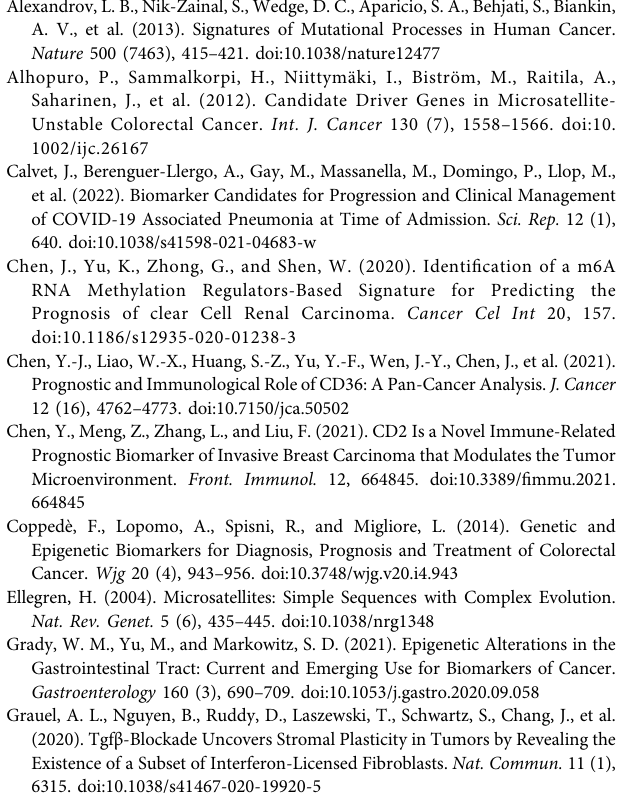
Supplementary Figure 5 | Kaplan-Meier analysis for DSS according to OAS3 expression. Only statistically signi fi cant cancers ( p -value < 0.05) are listed.